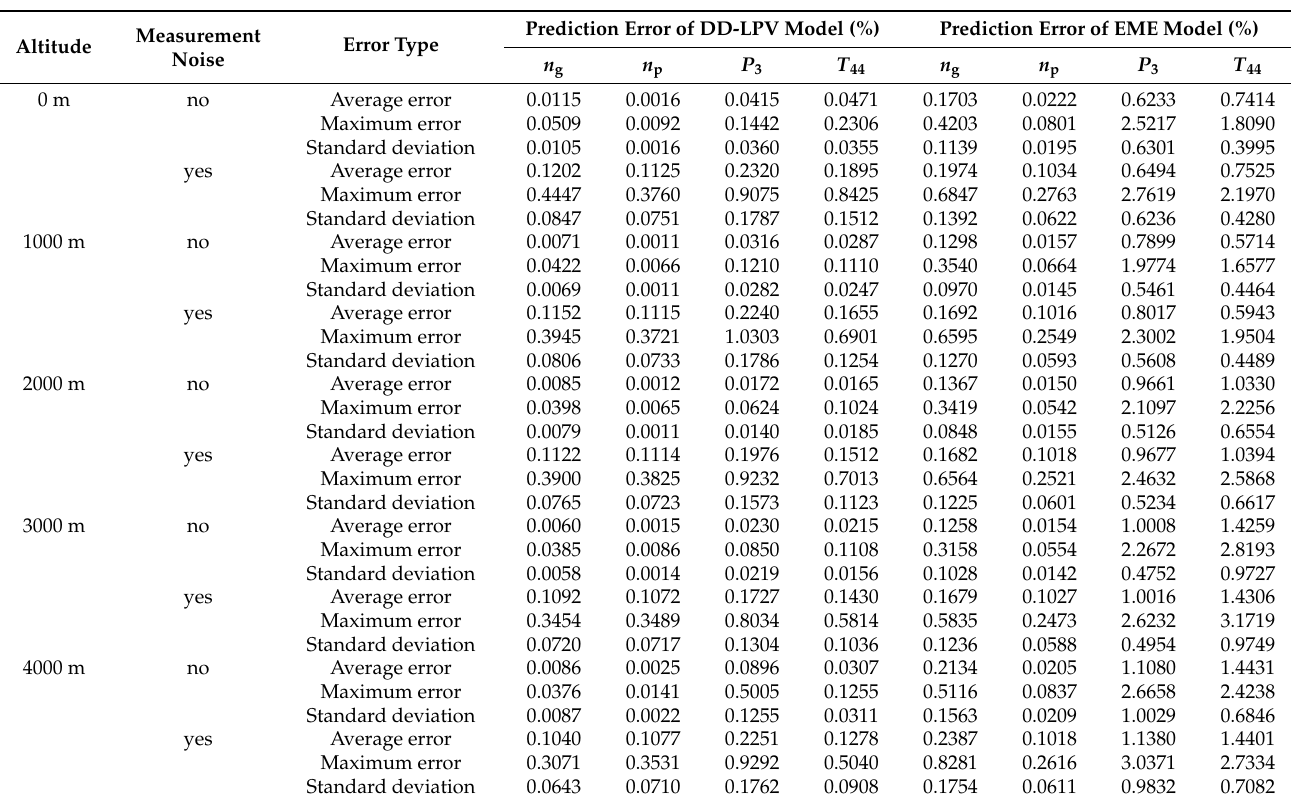
Table 1. Online prediction comparations of DD-LPV model and EME model at time k + 5 in flight envelope. Measurement Altitude